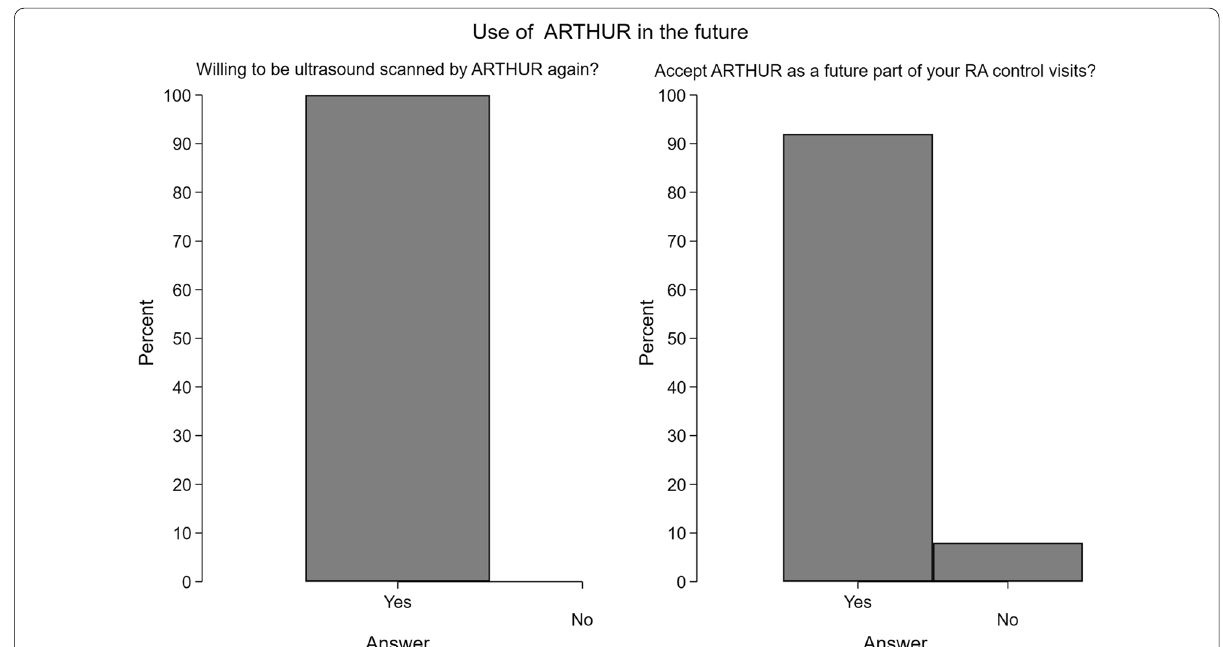
Fig. 6 Patient’s willingness to be ultrasound scanned by ARTHUR again and accept ARTHUR as part of future RA control